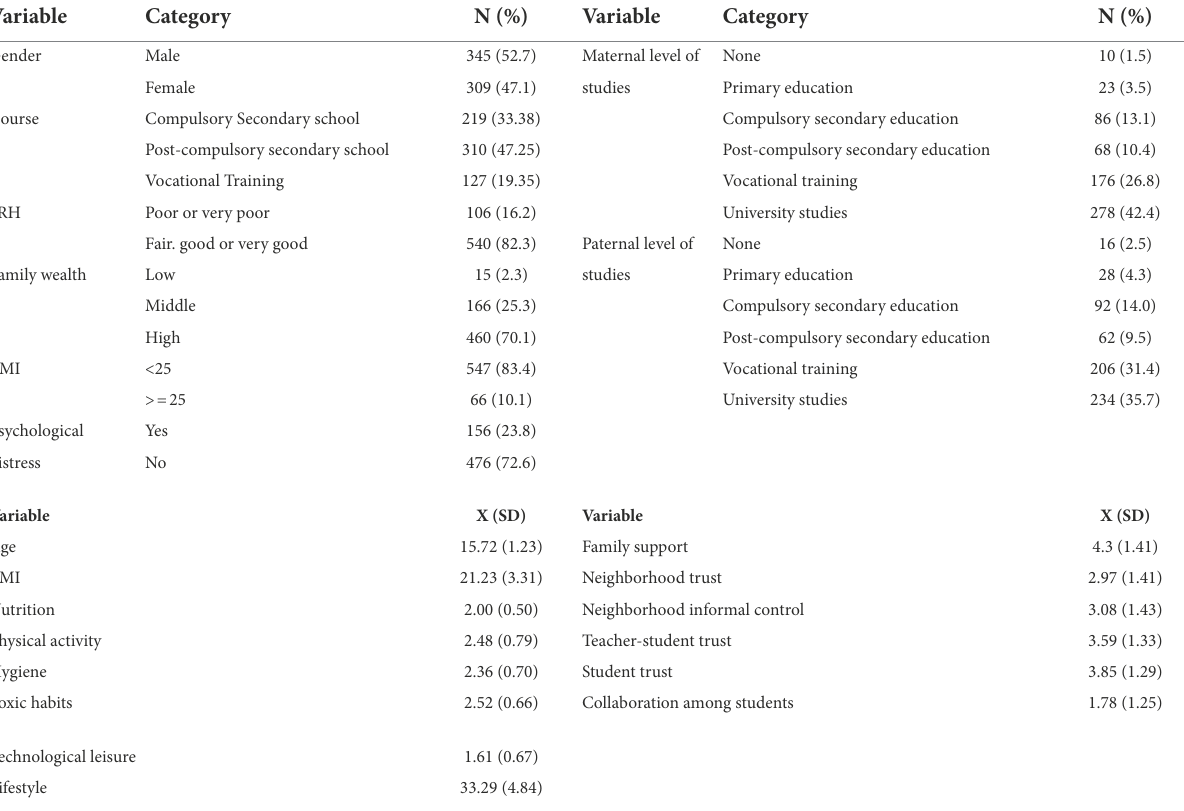
TABLE 1 Descriptive statistics of the